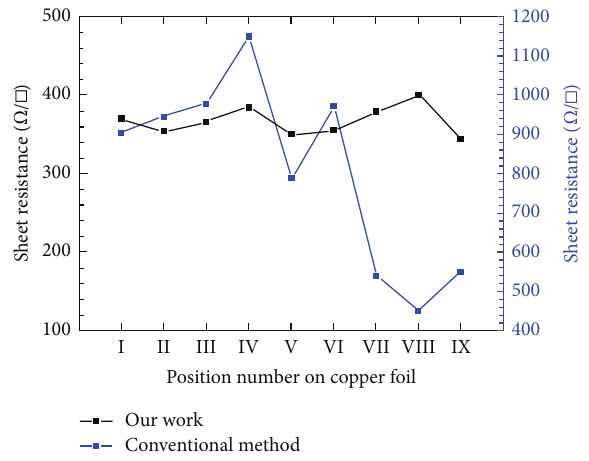
Figure 3: The comparison of the standing copper method and the conventional method on the electrical